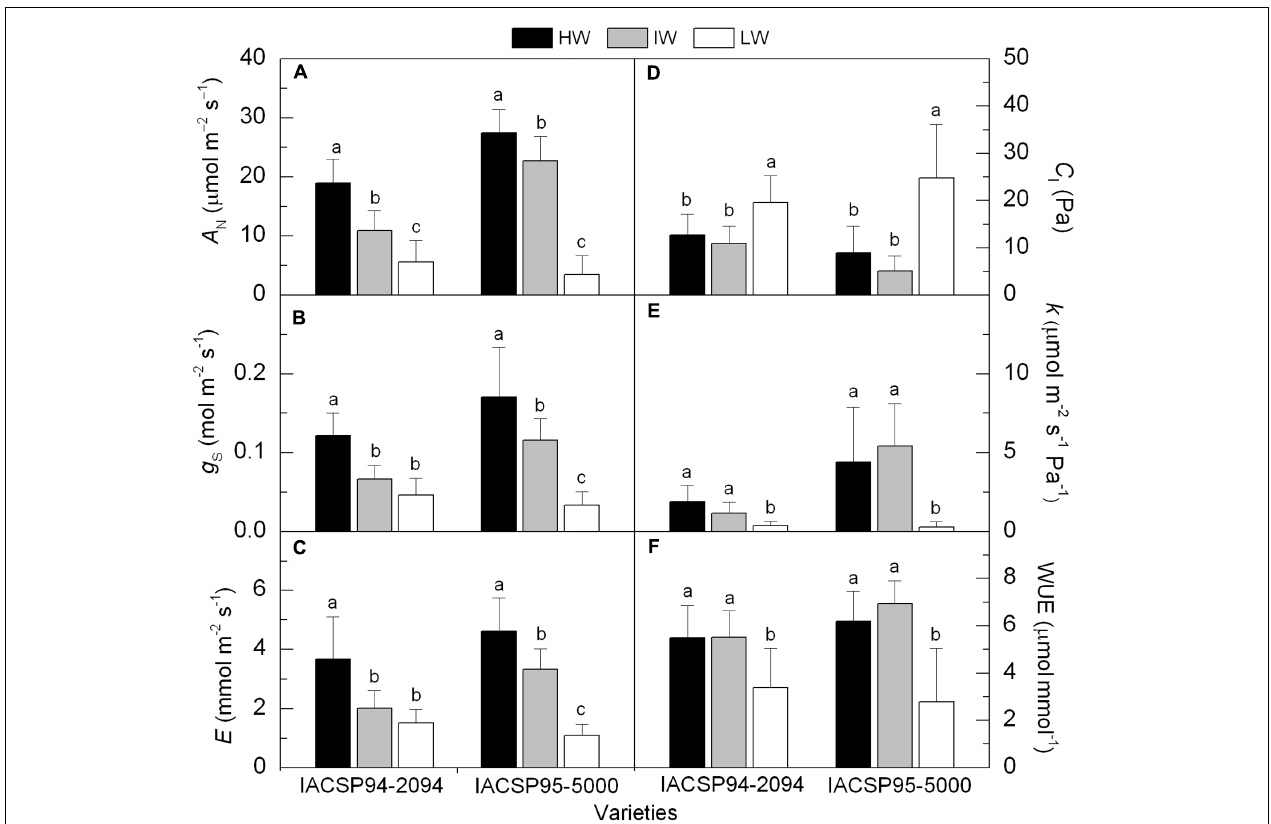
FIGURE 2 | CO 2 assimilation ( A N , in A ), stomatal conductance ( g S , in B ), transpiration ( E , in C ), intercellular CO 2 partial pressure ( C I , in D ), instantaneous carboxylation efficiency ( k , in E ) and actual photosynthetic water use efficiency (WUE, in F ) of sugarcane varieties IACSP94-2094 and IACSP95-5000 exposed to high (HW, in black), intermediate (IW, light gray) and low (LW, white) water availability. The histograms represent mean values ( n = 15) + SD. Lowercase letters compare water regimes in each variety (Student’s t , p < 0.05).